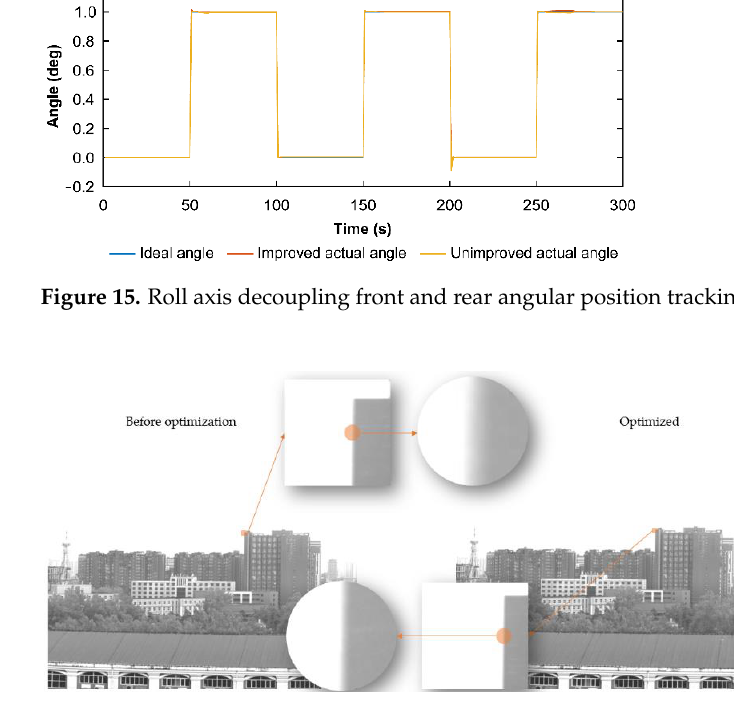
Figure 16. Comparison results of outdoor